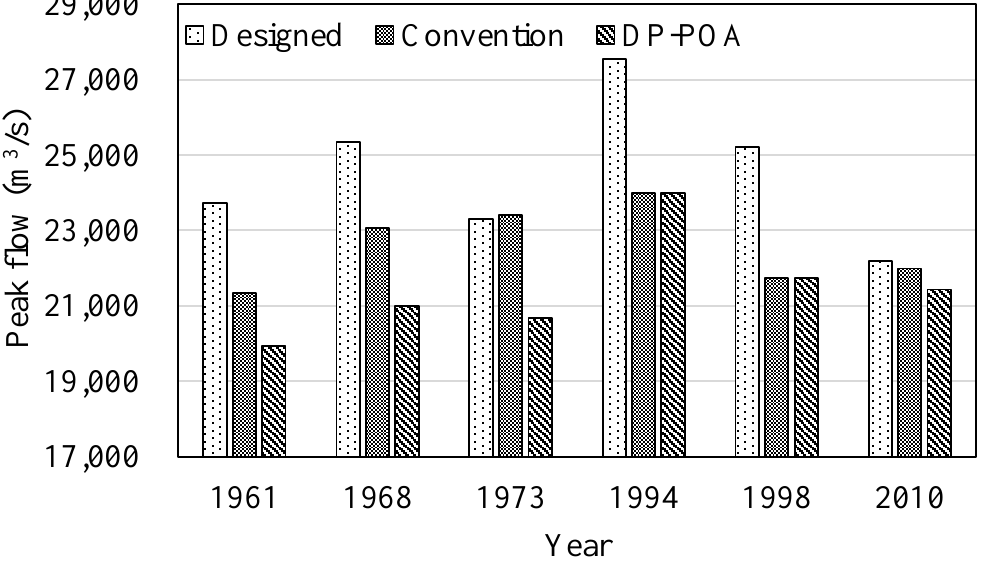
Figure 6. Flood peaks of the Shishang flood control point with 100-year return period.